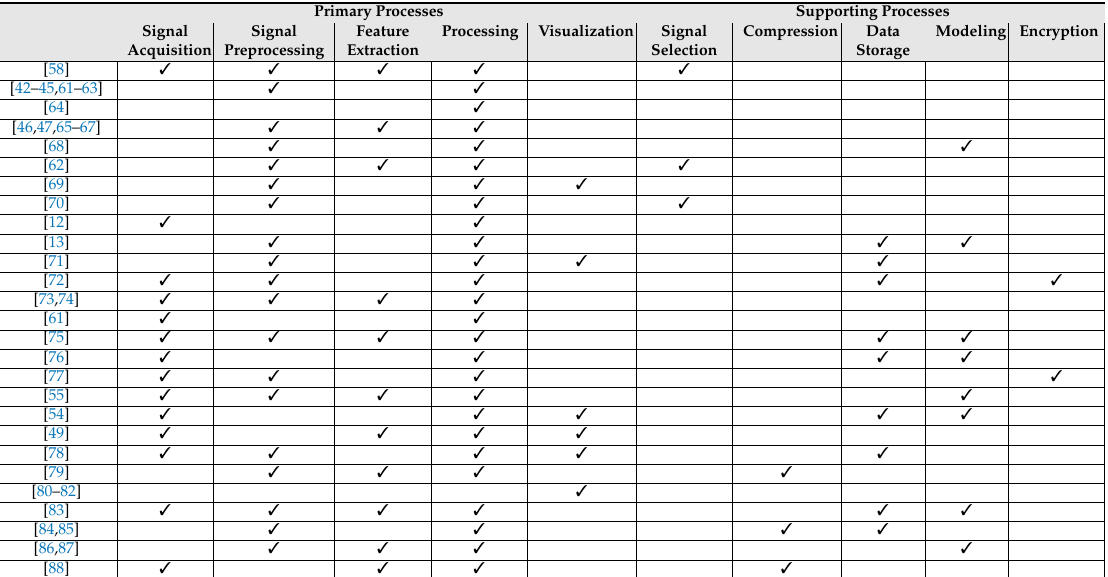
Table 1. Summary of the most common literature referring to ECG monitoring systems’ lifecycles, primary and supporting